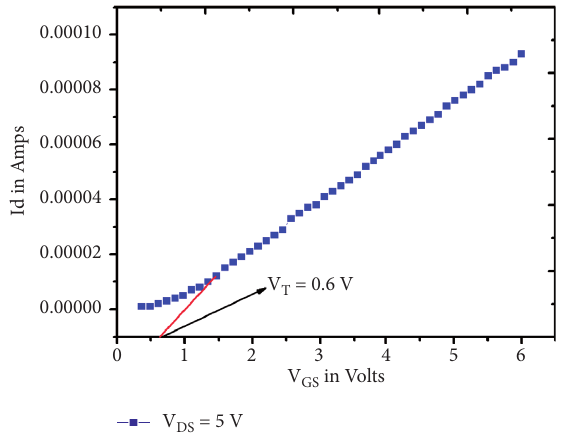
Figure 12: Transfer characteristics of V 2 O 5 thin film gate dielectric of Si-MOSFET (square root of drain current vs. V GS ).